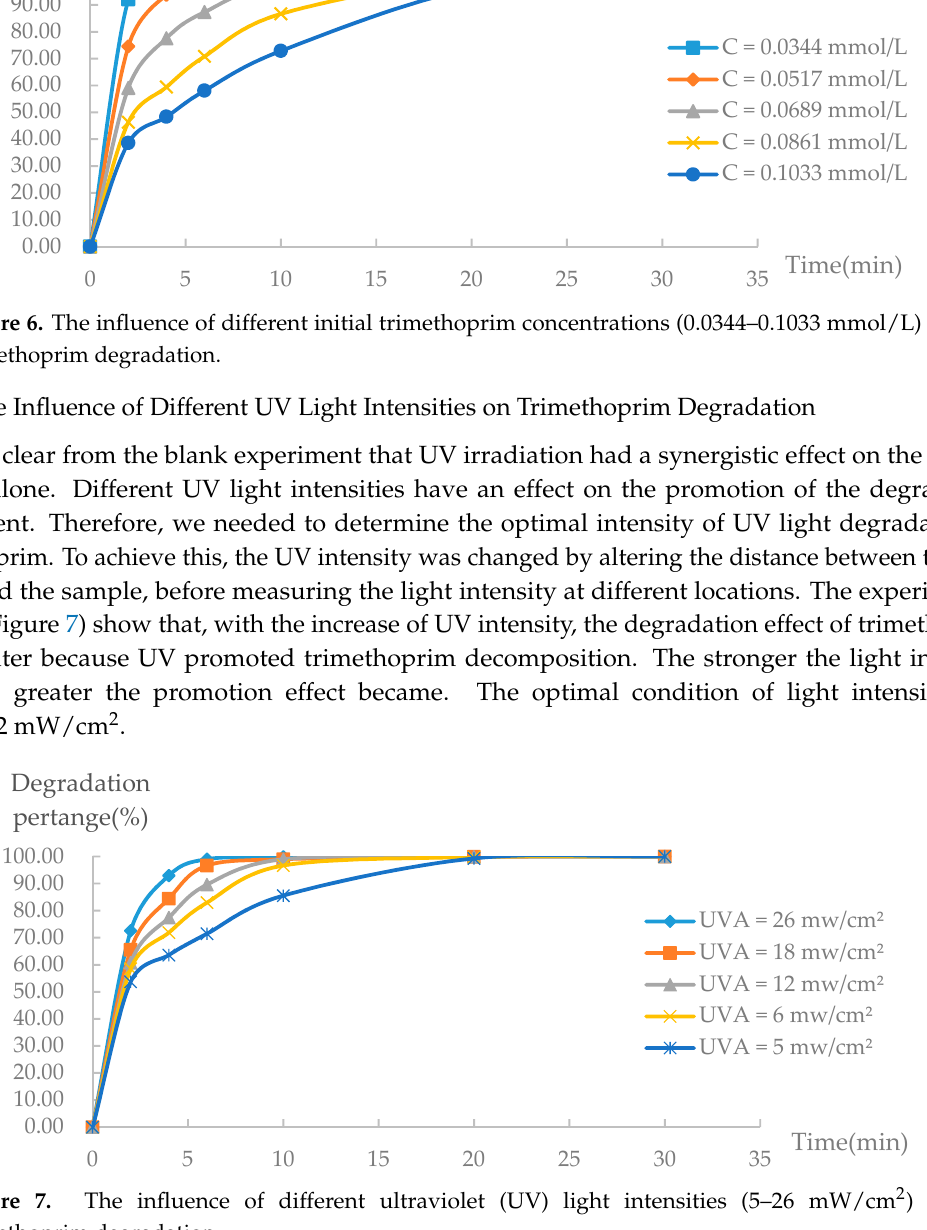
Figure 6. The influence of different initial trimethoprim concentrations (0.0344–0.1033 mmol/L) on trimethoprim degradation.